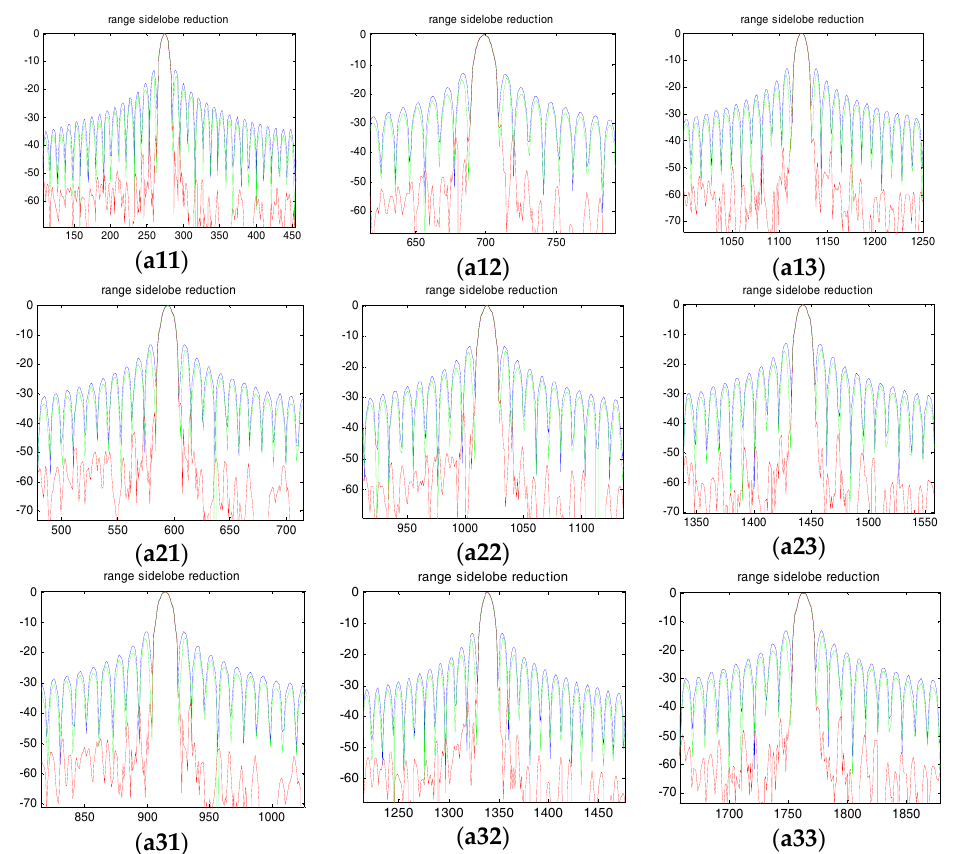
Figure 11. Range profiles for the nine points. ( a11 ~ a33 ) are the nine points’ range profiles, respectively.